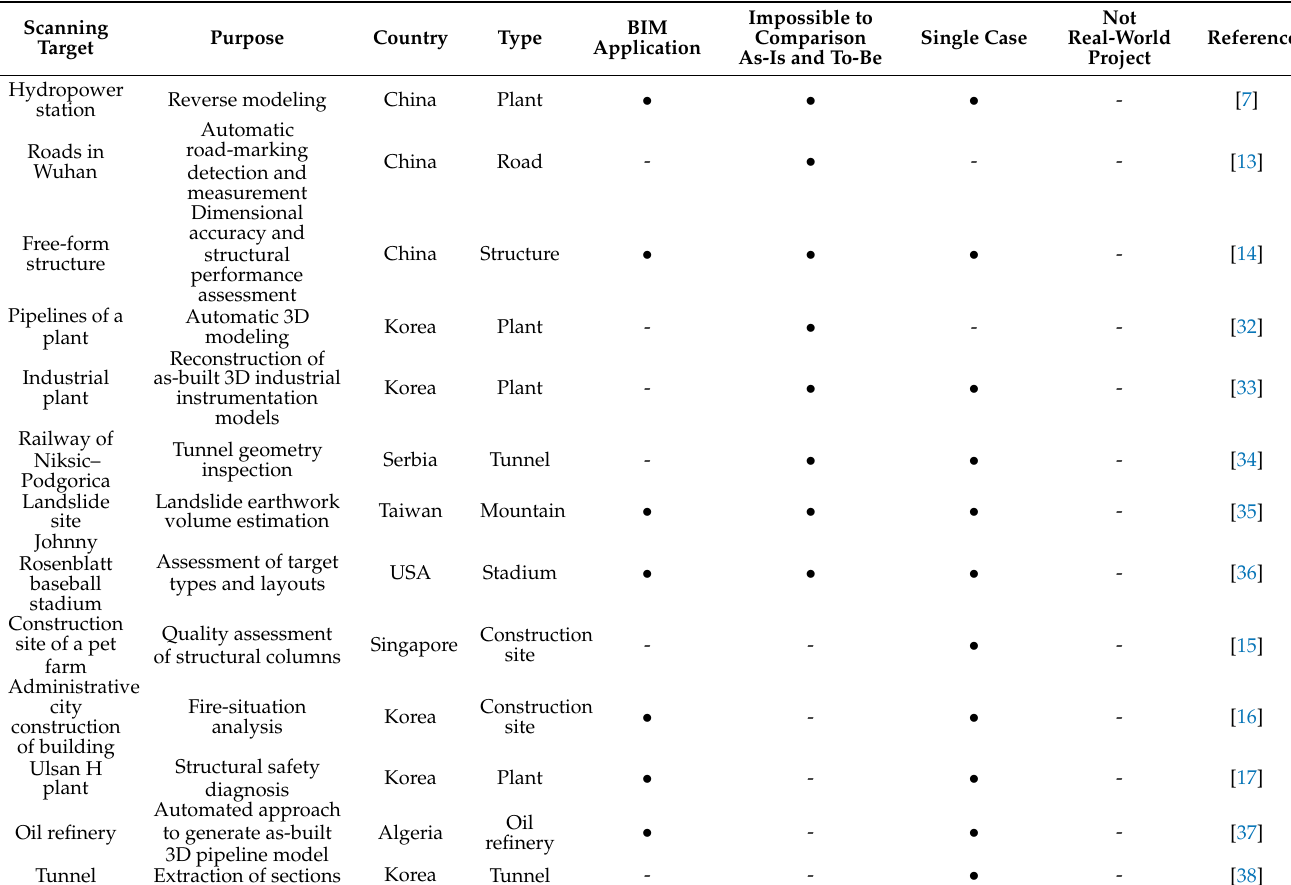
Table 1. Details of the gaps in research areas related to